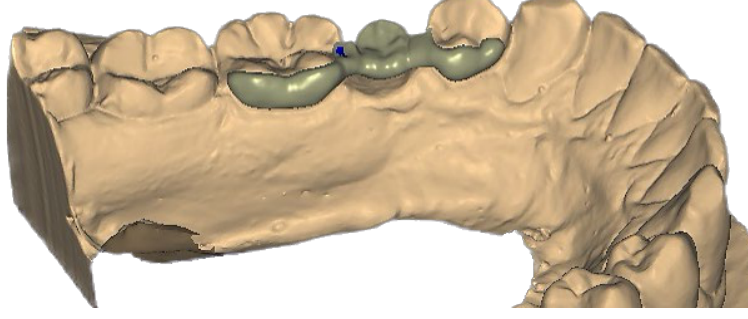
Figure 1. Preparation of RBP based on a pre-operative digital impression.